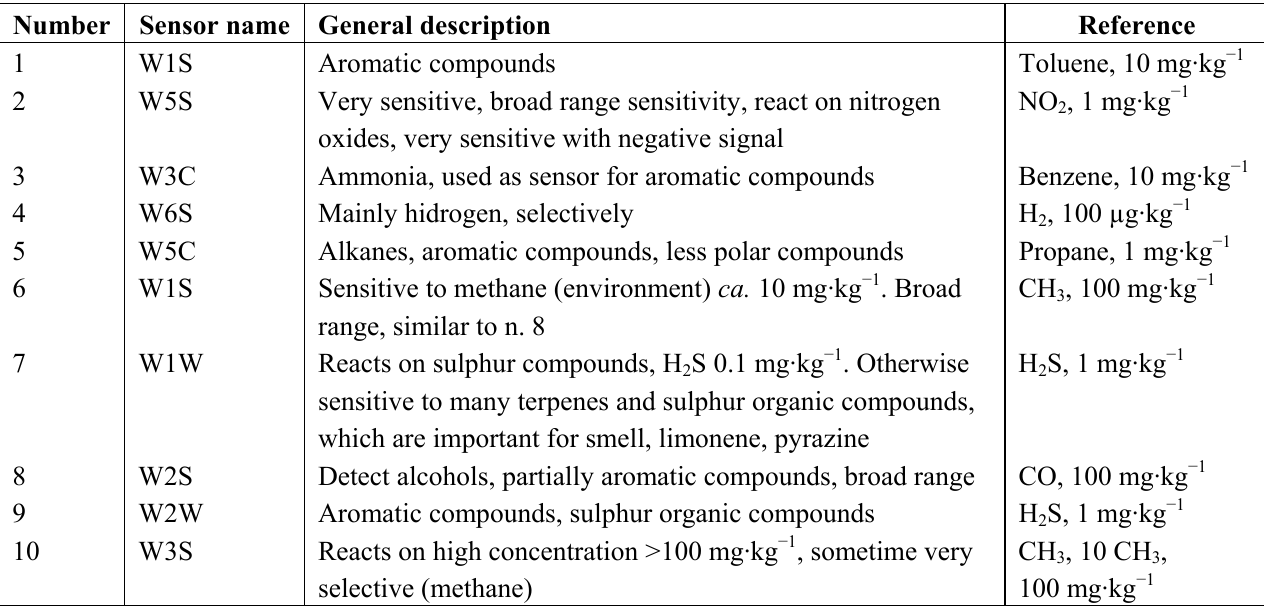
Table 1. Description of the sensors installed in the portable electronic nose PEN3